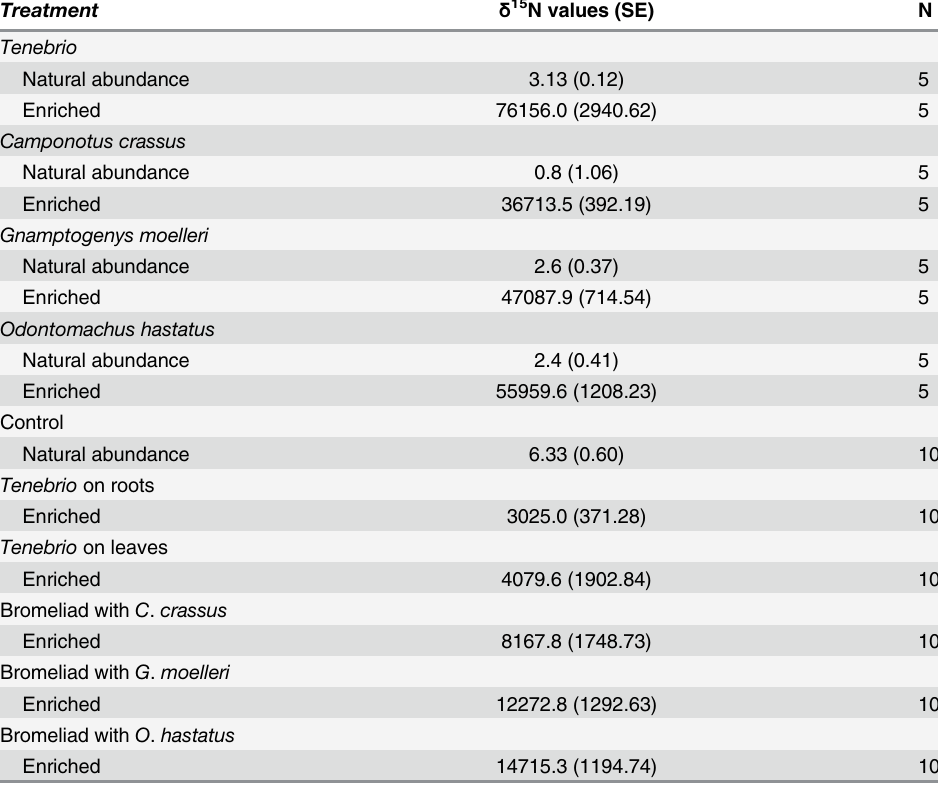
Table 1. δ 15 N values. Average δ 15 N values of natural abundance and enriched Tenebrio larvae, Campono- tus crassus , Gnamptogenys moelleri and Odontomachus hastatus ants, and Quesnelia arvensis leaves receiving the following treatments: control; Tenebrio among roots; Tenebrio on leaves; Camponotus crassus ants and Tenebrio ; Gnamptogenys moelleri and Tenebrio ; and Odontomachus hastatus and Tenebrio